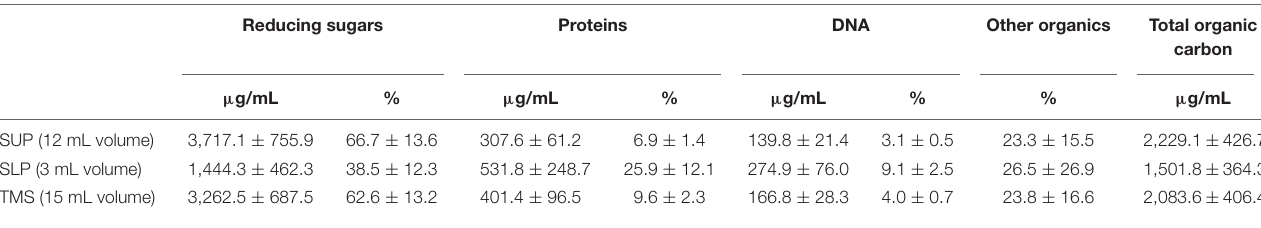
TABLE 3 | Composition of the organic material of the extracted C. acnes RT5 biofilm